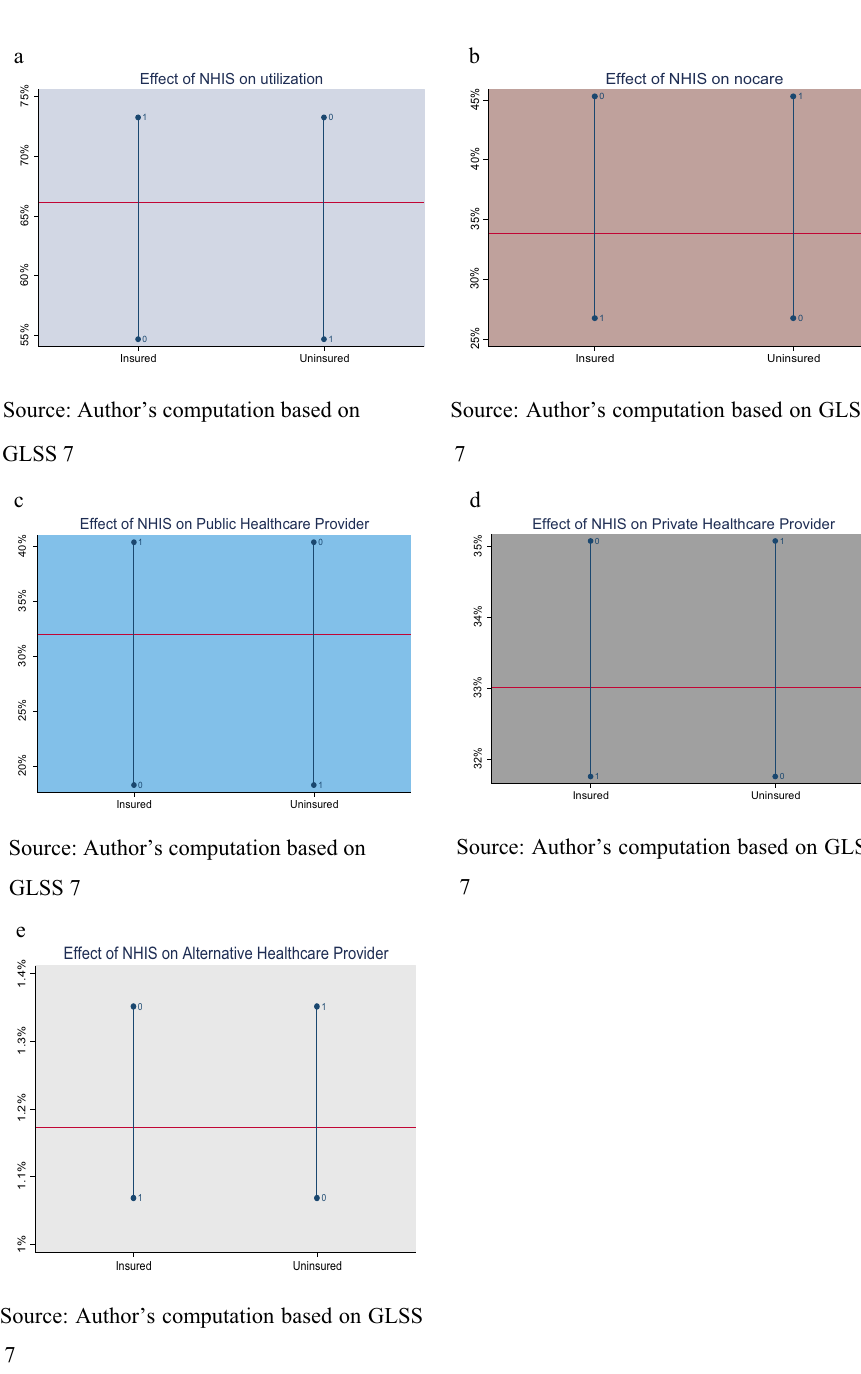
Fig. 5 Effect of NHIS on healthcare utilization and the types of healthcare. The effect of the National Health Insurance Scheme on healthcare utilization is shown on Fig. 5a to 5e. It begins with general healthcare services followed by the types of healthcare — Nocare, Public, Private, and Medical Alternative. It is a mean graph that measures the likelihood of seeking healthcare. The horizontal line is the mean benchmark for healthcare utilization of the sample. The percentages are the benchmarks for comparison in order to conclude whether or not insurance status has increased healthcare utilization, and from what type of healthcare provider. Insurance status is dichotomized and takes the value of 1 if insured, and 0 if otherwise (indicated on the vertical line). The uninsured category also takes the value of 1 if uninsured and 0 if otherwise. If the value of 1 is above (below) the benchmark which is the horizontal line, then utilization is increased (decreased). Details of the Figure are as follows: a : Effect of NHIS on general healthcare services. b : Effect of NHIS on